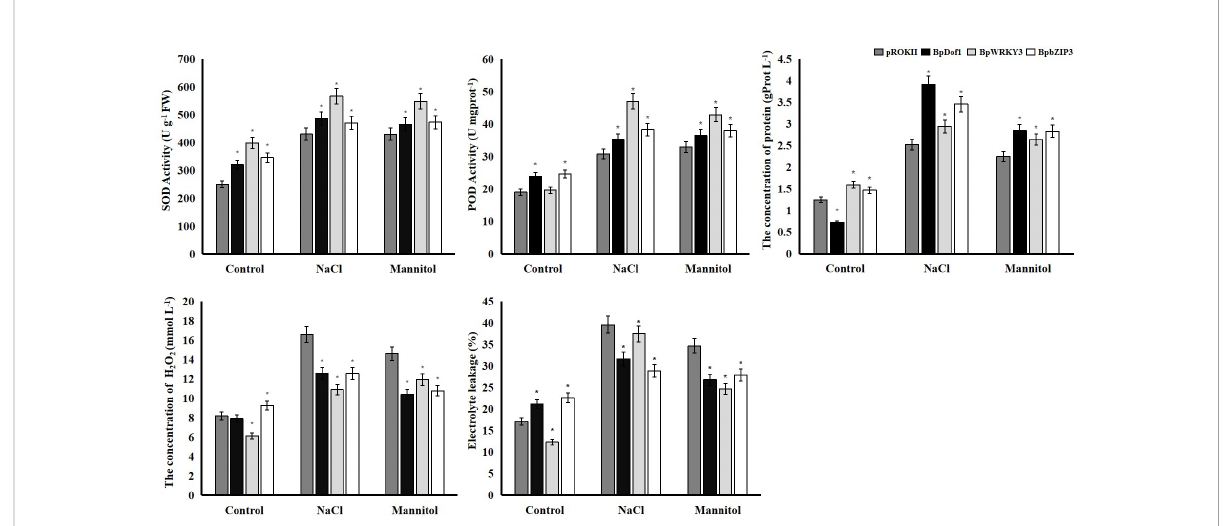
FIGURE 12 Physiological analyses of overexpressing BpDof1 , BpWRKY3 , and BpbZIP3 plants under salt and osmotic stress. Birch plants overexpressing BpDof1 , BpWRKY3 , and BpdZIP3 were generated by transient transformation method. The empty pROKII was transiently transformed into birch plants. All birch plants were treated using salt of 150 mM NaCl and mannitol of 200 mM for 12 h. Plants watered with fresh water were used as control. All birch plants were individually detected the activity of SOD and POD, content of protein and H 2 O 2 and electrolyte leakage. The error bars indicate the standard deviation of three biological replicates. * indicates a signi fi cant difference ( P <